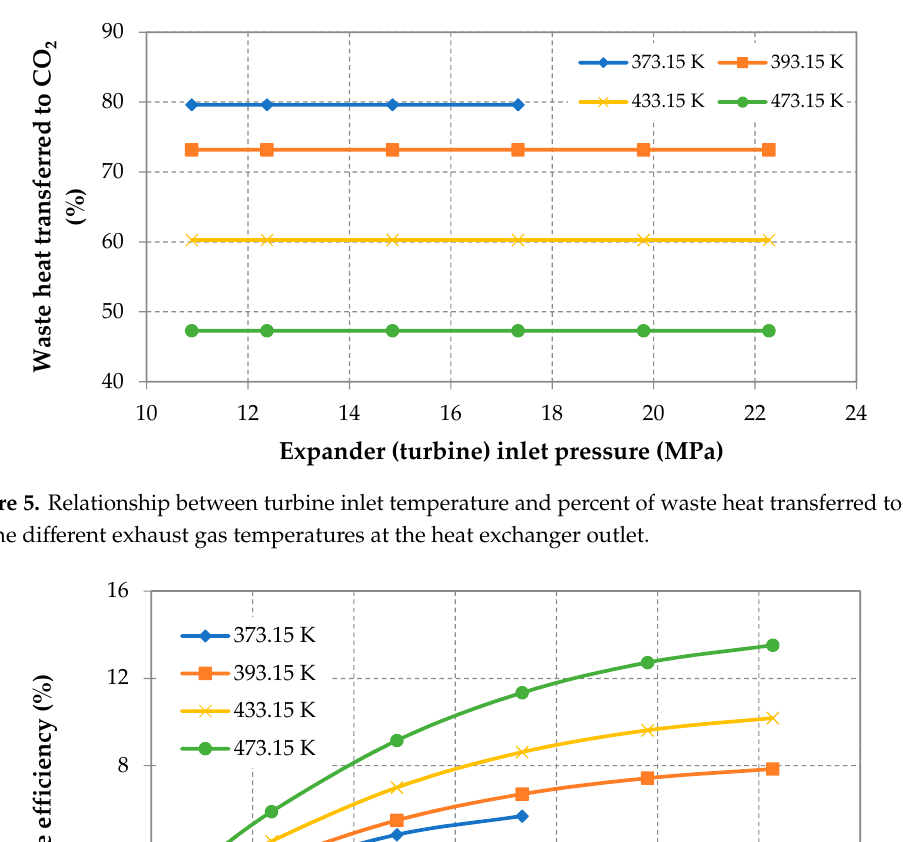
Figure 5 . Relationship between turbine inlet temperature and percent of waste heat transferred to CO 2 for the different exhaust gas temperatures at the heat exchanger outlet.